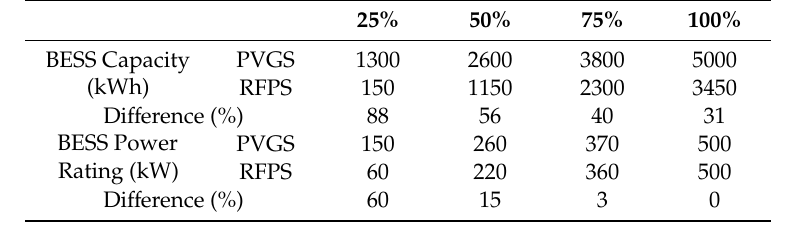
Table 4. BESS capacity and power rating for both strategies with a one year simulation period.